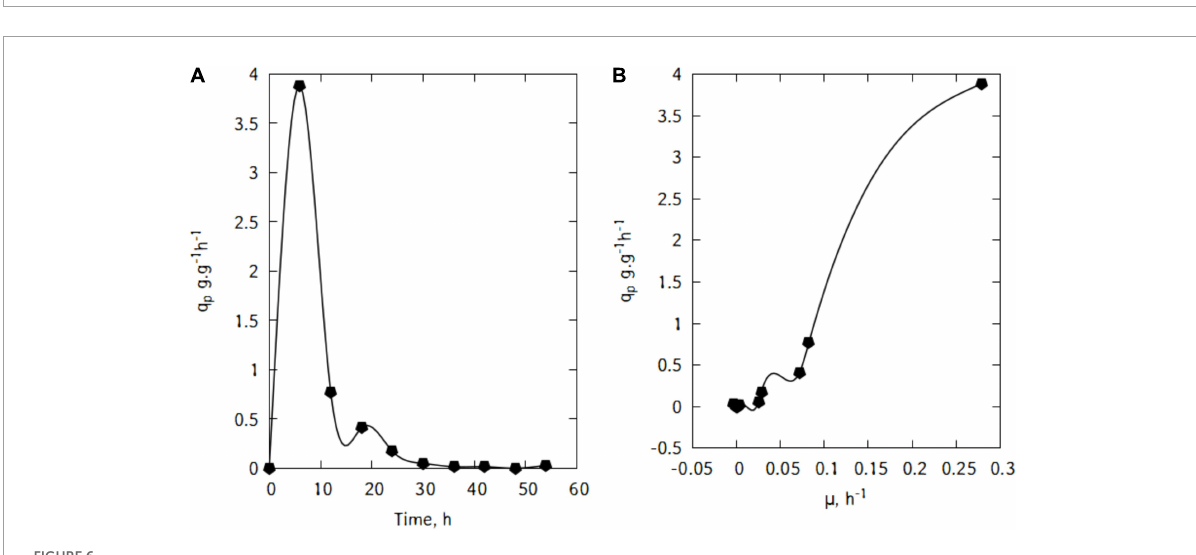
FIGURE6 Specific lactic acid production (A) , and correlation between q p and µ during cultivation of L. casei in traditional cheese whey (B)